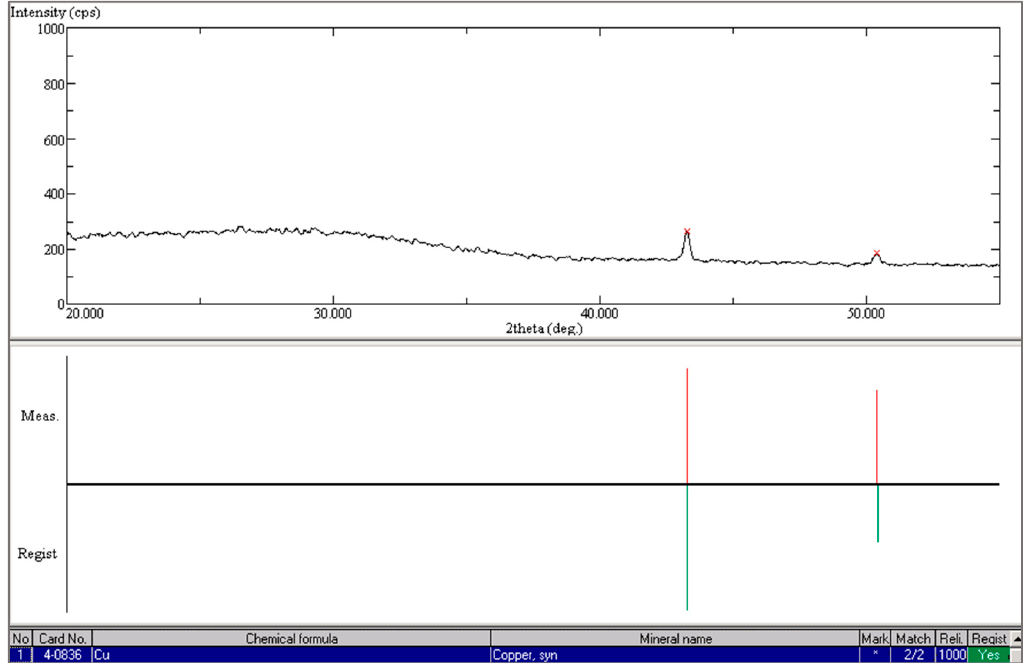
Figure 26. X-ray diffraction pattern only showing the presence of metallic copper. No SnO 2 could be detected Figure 26. X-ray di ff raction pattern only showing the presence of metallic copper. No SnO 2 could be